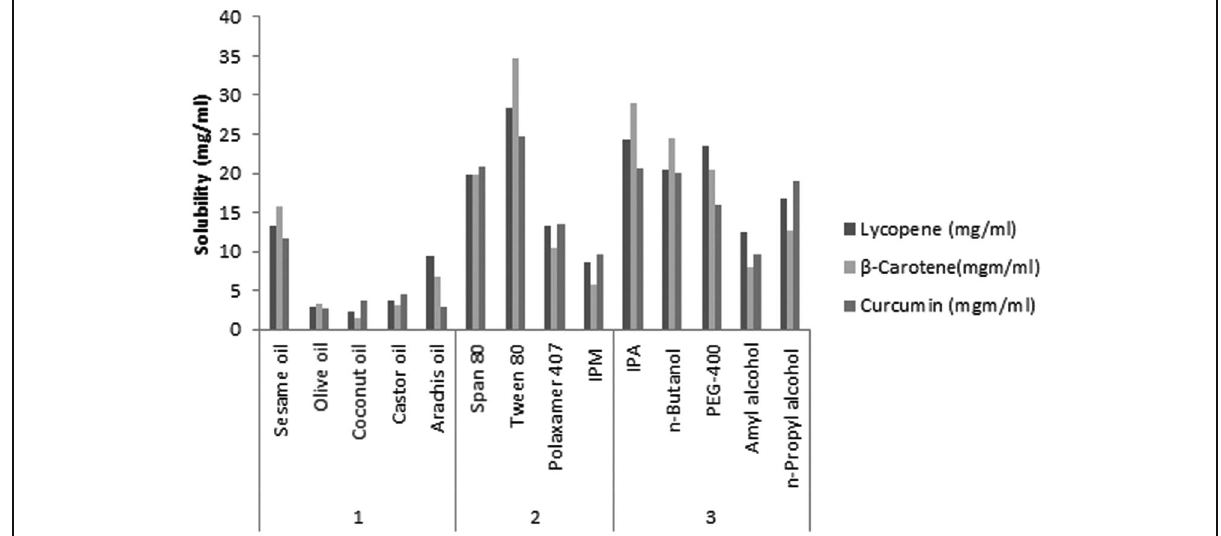
Fig. 1 Solubility of lycopene, β -carotene and curcumin in different oils (1), surfactants (2) and cosurfactants